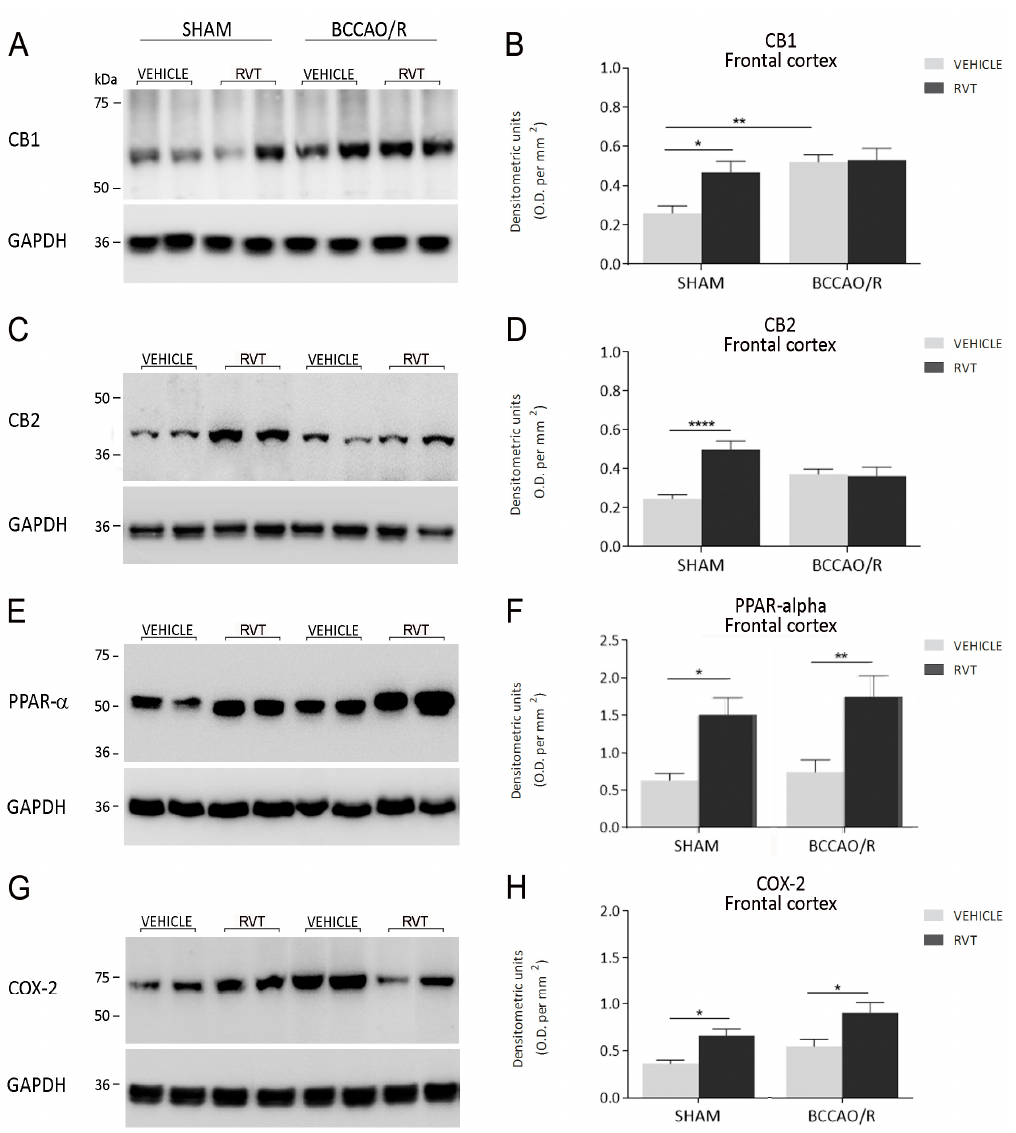
Figure 2. Western blot analysis of cannabinoid receptors CB1 ( A , B ) and CB2 ( C , D ), peroxisome-proliferator activated receptor- α (PPAR- α ) ( E , F ) and cyclooxygenase-2 (COX-2) ( G , H ) in the frontal cortex of sham-operated and bilateral common carotid artery occlusion followed by reperfusion (BCCAO/R) vehicle-treated and RVT pre-treated rats, respectively. ( B , D , F , H ) densitometric analysis of the band gray levels expressed as a percentage of the optical density (O.D.) ratio of CB1, CB2, PPAR- α - and COX-2-immunostained bands to those of GAPDH. Data are reported as the mean values of 12 sham-operated and 12 BCCAO/R rats and 10 RVT pre-treated, either sham or BCCAO/R, rats. Error bars depict the standard error of the mean (S.E.M.). Asterisks denote significant differences. Two-way ANOVA with the Bonferroni’s test for post hoc analyses was applied to evaluate statistical differences between groups. * p < 0.05; ** p < 0.01; **** p < 0.0001 (see Table 1 for F - and p -values relevant to effects of BCCAO/R and RVT pre-treatment and to the interaction between them).